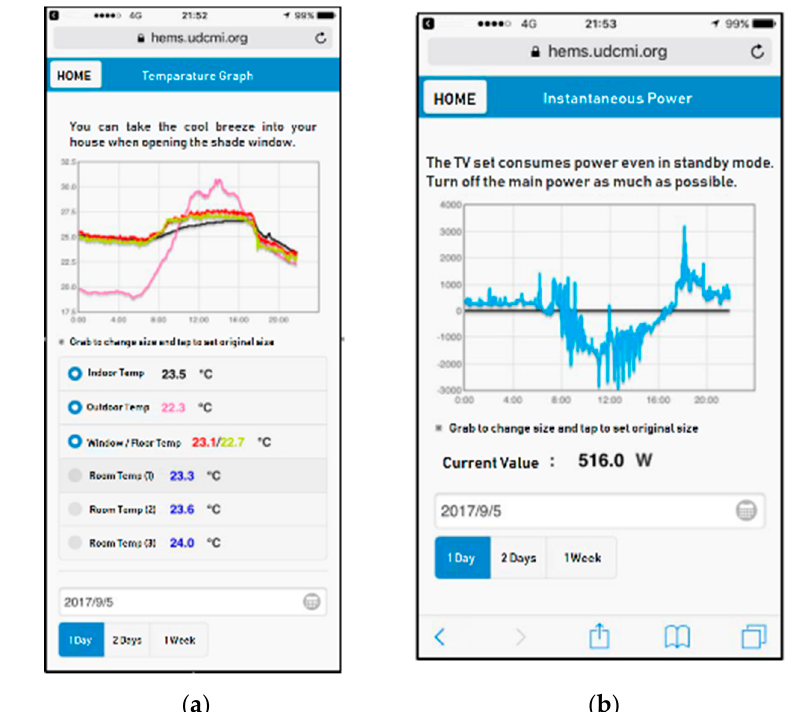
Figure 6. Screenshots of the smartphone application: ( a ) Room environment information ( b ) electricity usage information.